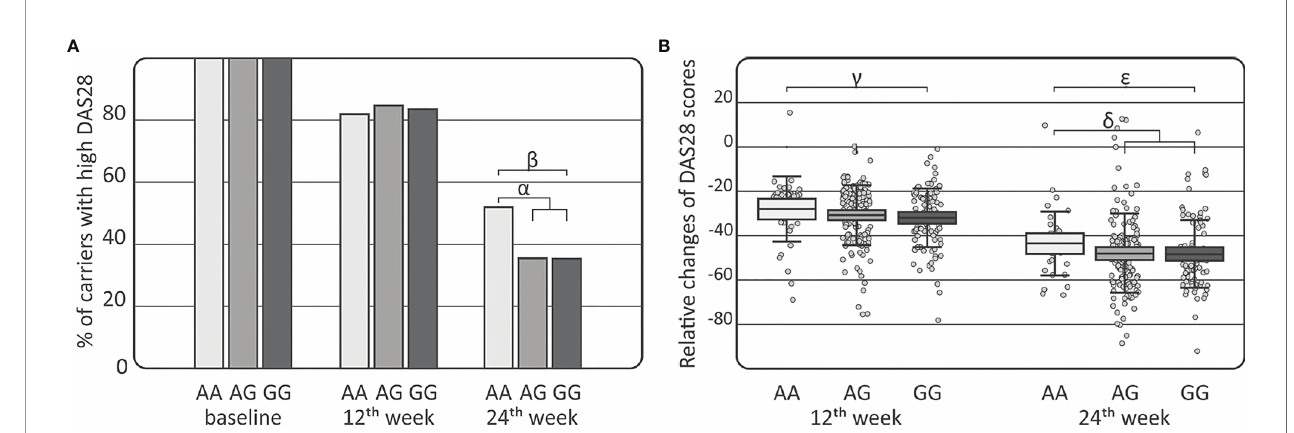
FIGURE 2 | Association of the IL-33 rs16924159 polymorphism with disease activity in rheumatoid arthritis patients. (A) Comparison of IL-33 rs16924159 genotype frequencies with DAS28 score at baseline as well as at 12th and 24th weeks after commencing of anti-TNF therapy; (B) Comparison of IL-33 rs16924159 genotype frequencies with relative change in DAS28 between baseline and 12th week, as well as 24th week after commencing of anti-TNF therapy; Differences are indicated as; a AA vs AG+GG, p =0.023, p c =NS, OR= 1.97, CI 95% =(1.06; 3.67); b GG vs AA, p =0.049, p c =NS, OR=0.51, CI 95% =(0.25; 1.00); g AA vs GG, p =0.036, p c =NS, W=2396.5; d AA vs AG+GG, p =0.030, p c =NS, W=5265.5; ϵ GG vs AA, p =0.016, p c =NS, W=2301.0; DAS28, disease activity score 28; NS, non-signi fi cant; p c , value with Bonferroni